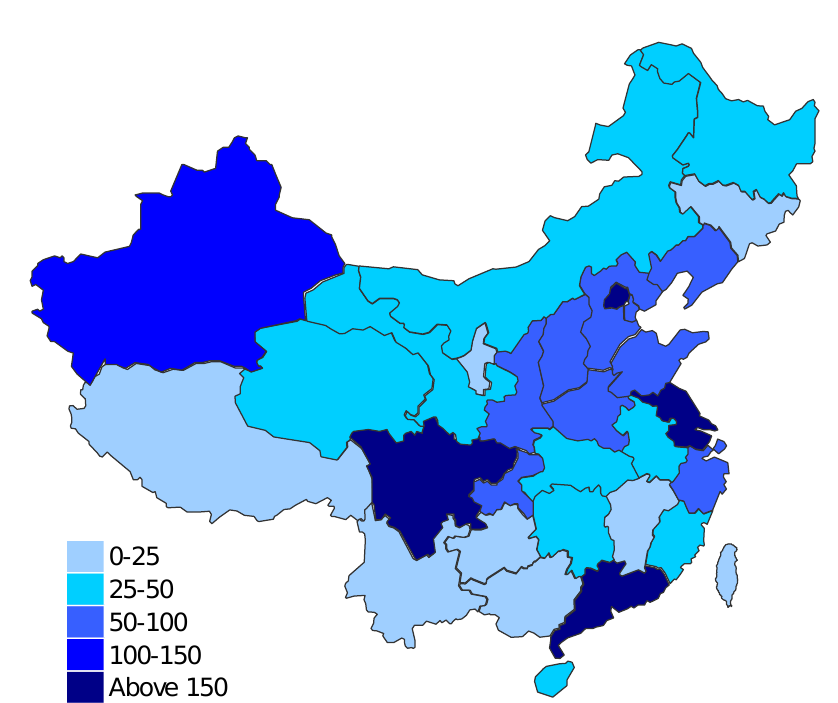
Figure 5. Natural Gas Consumption in China by Province in 2016 (10 8 cu.m). Figure5. Natural Gas Consumption in China by Province in 2016 (10 8 cu.m). Figure5. Natural Gas Consumption in China by Province in 2016 (10 8 cu.m).